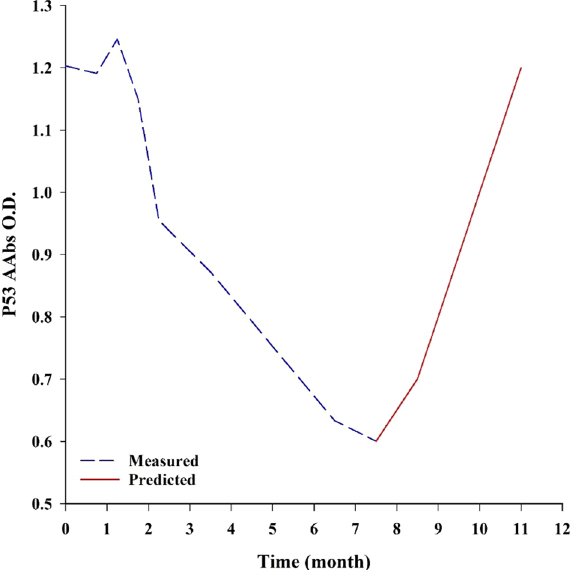
Figure 6. Measured and predicted values of P53 in a cat with a mammary tumor. The intersection between measured and predicted values marks the end of the PPTT treatment course. Figure was prepared using SigmaPlot v14.0 (Systat Software, San Jose, CA,